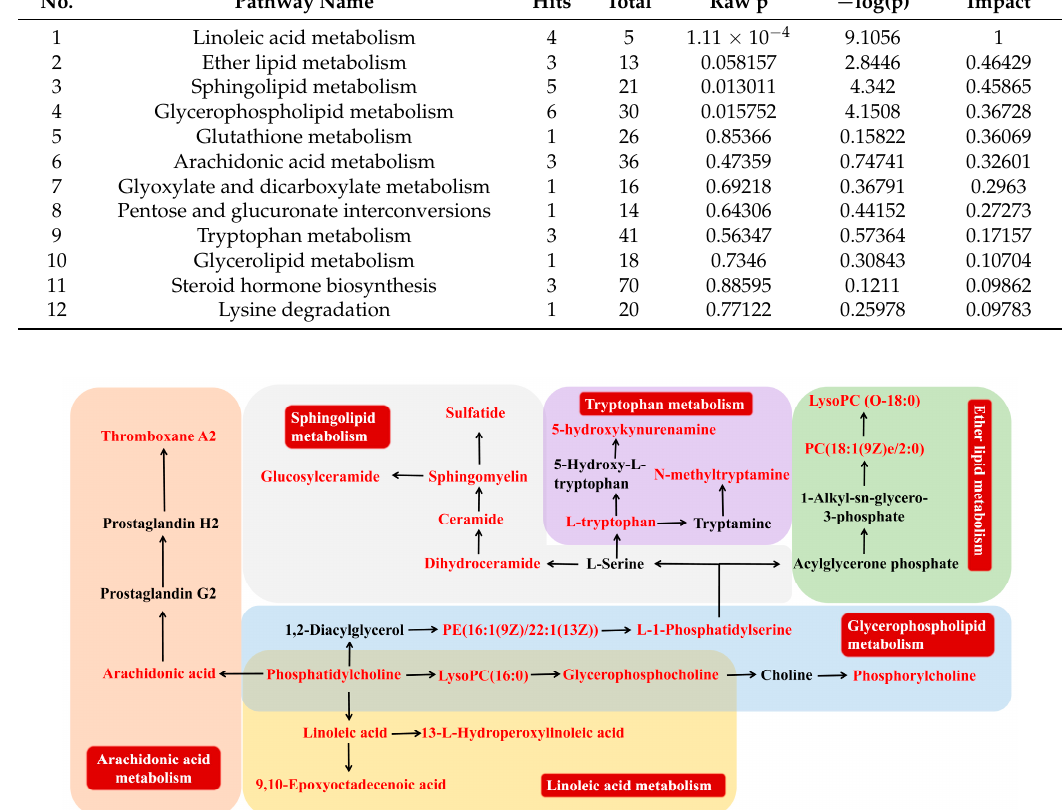
Figure 5. Metabolic networks of potential metabolite markers in response to the preventive effect of EZ for acute blood stasis. The identified metabolite markers are highlighted in red.